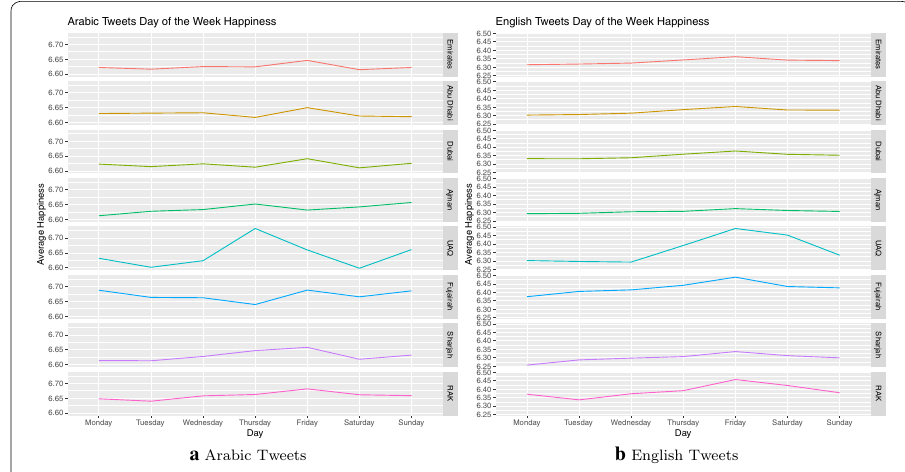
Fig. 7 Tweets average happiness across days of the week